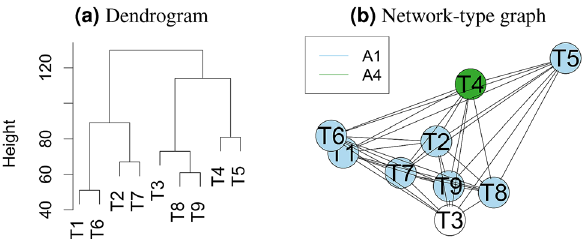
Figure 8. Dendrogram from hierarchical cluster analysis ( a ) and network-type graphs ( b ) for assessing the similarity of tasks based on challenge rankings. A dendrogram ( a ) is a visualization approach based on hierarchical clustering, a method comprehensively described in 27 . It depicts clusters according to a distance measure (here: Spearman’s footrule (see “Comparison and aggregation of rankings”)) and an agglomeration method (here: complete agglomeration). In network-type graphs ( b ) 9 , every task is represented by a node, and nodes are connected by edges, the length of which is determined by a distance measure (here: Spearman’s footrule). Hence, tasks that are similar with respect to their algorithm ranking appear closer together than those that are dissimilar. Nodes representing tasks with a unique winner are color coded by the winning algorithm. If there is more than one first-ranked algorithm in a task, the corresponding node remains uncolored.